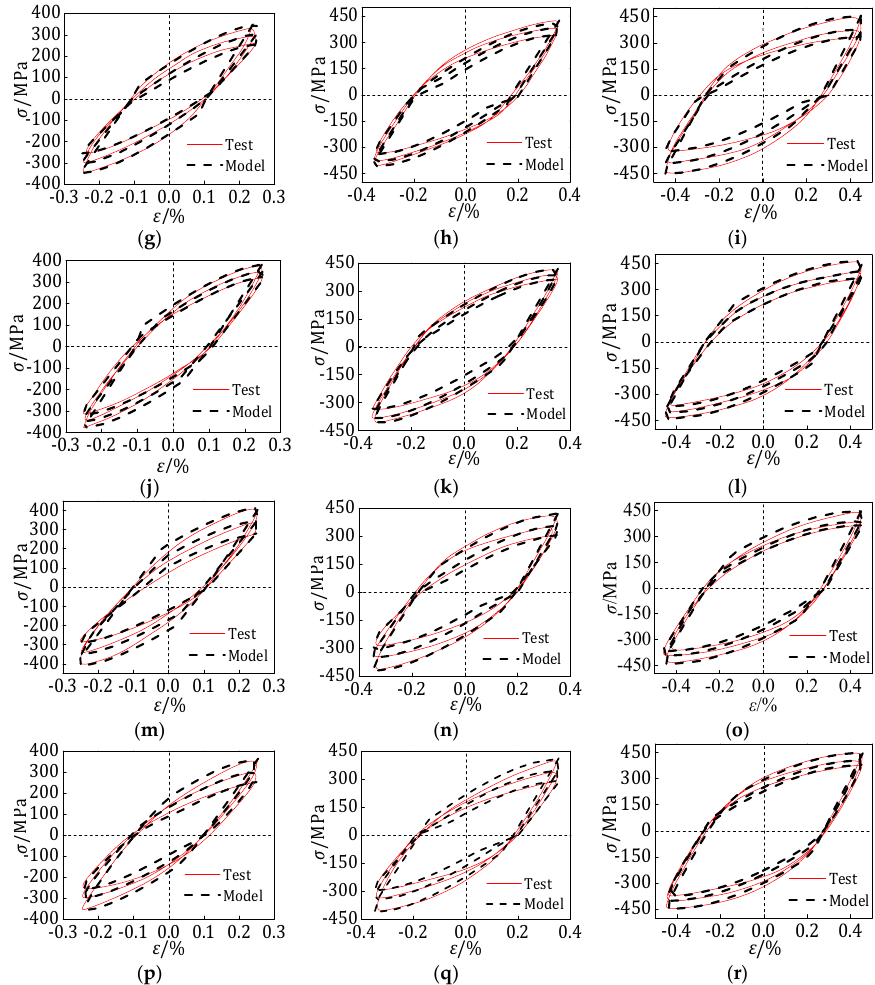
Figure 16. Comparison of hysteretic curves calculated from welding hysteresis models and test results.( a ) WA1(1) σ - ε ; ( b ) WA1(2) σ - ε ; ( c ) WA1(3) σ - ε ; ( d ) WA2(1) σ - ε ; ( e ) WA2(2) σ - ε ; ( f ) WA2(3) σ - ε